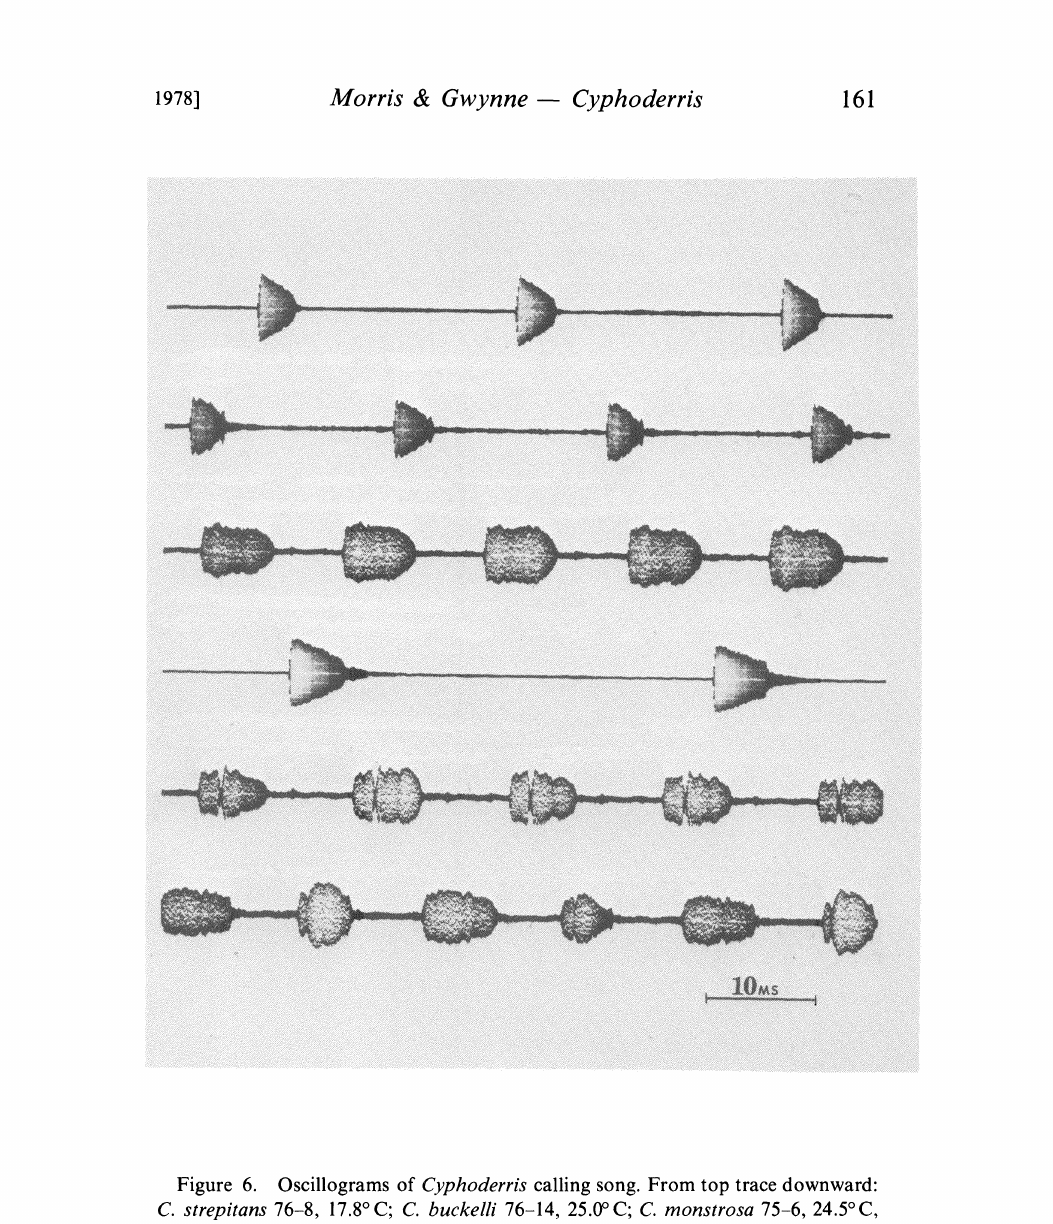
Figure 6. Oscillograms of Cyphoderris calling song. From top trace downward: C. strepitans 76-8, 17.8C; C. buckelli 76-14, 25.0C; C. monstrosa 75-6, 24.5C, intact file; C. monstrosa 76-2, 8.7C, field-recorded, Monck Prov. Pk B.C.; C. monstrosa 75-6, 24.0 C, file teeth of right forewing damaged; C. monstrosa 75-10, 23.1 C, male recorded singing in immediate presence of